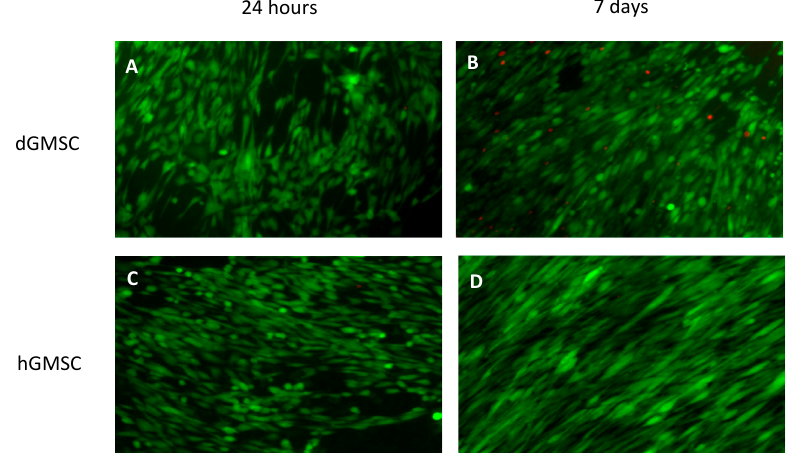
Figure 7. Live/Dead Assay of SEM of GMSC derived from diseased (dGMSC) and healthy (hGMSC) human gingiva at 24 h of culture. ( A , C ) represent the images at 24 h while ( B , D ) are taken at 7 days of culture.